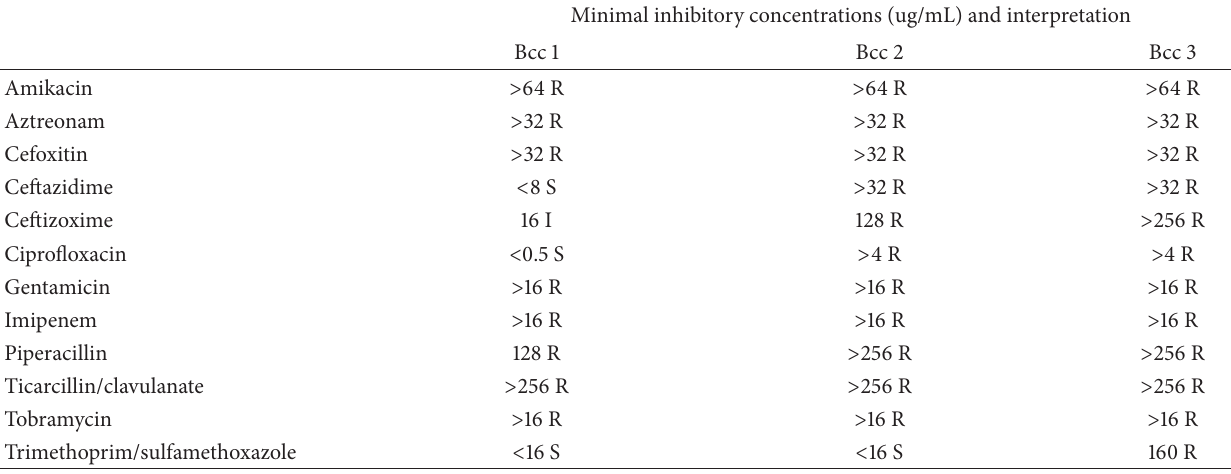
Table 2: Clinical, laboratory, and autopsy findings corresponding to acquired hemophagocytic lymphohistiocytosis diagnostic criteria. Hemophagocytic lymphohistiocytosis diagnostic criteria (diagnosis is established by fulfilling 5 out of 8 of the following) Fever Splenomegaly Cytopenia (affecting ≥ 2 cell lineages, hemoglobin < 9g/dL; platelets < 100G/L; neutrophils < 1.0G/L)